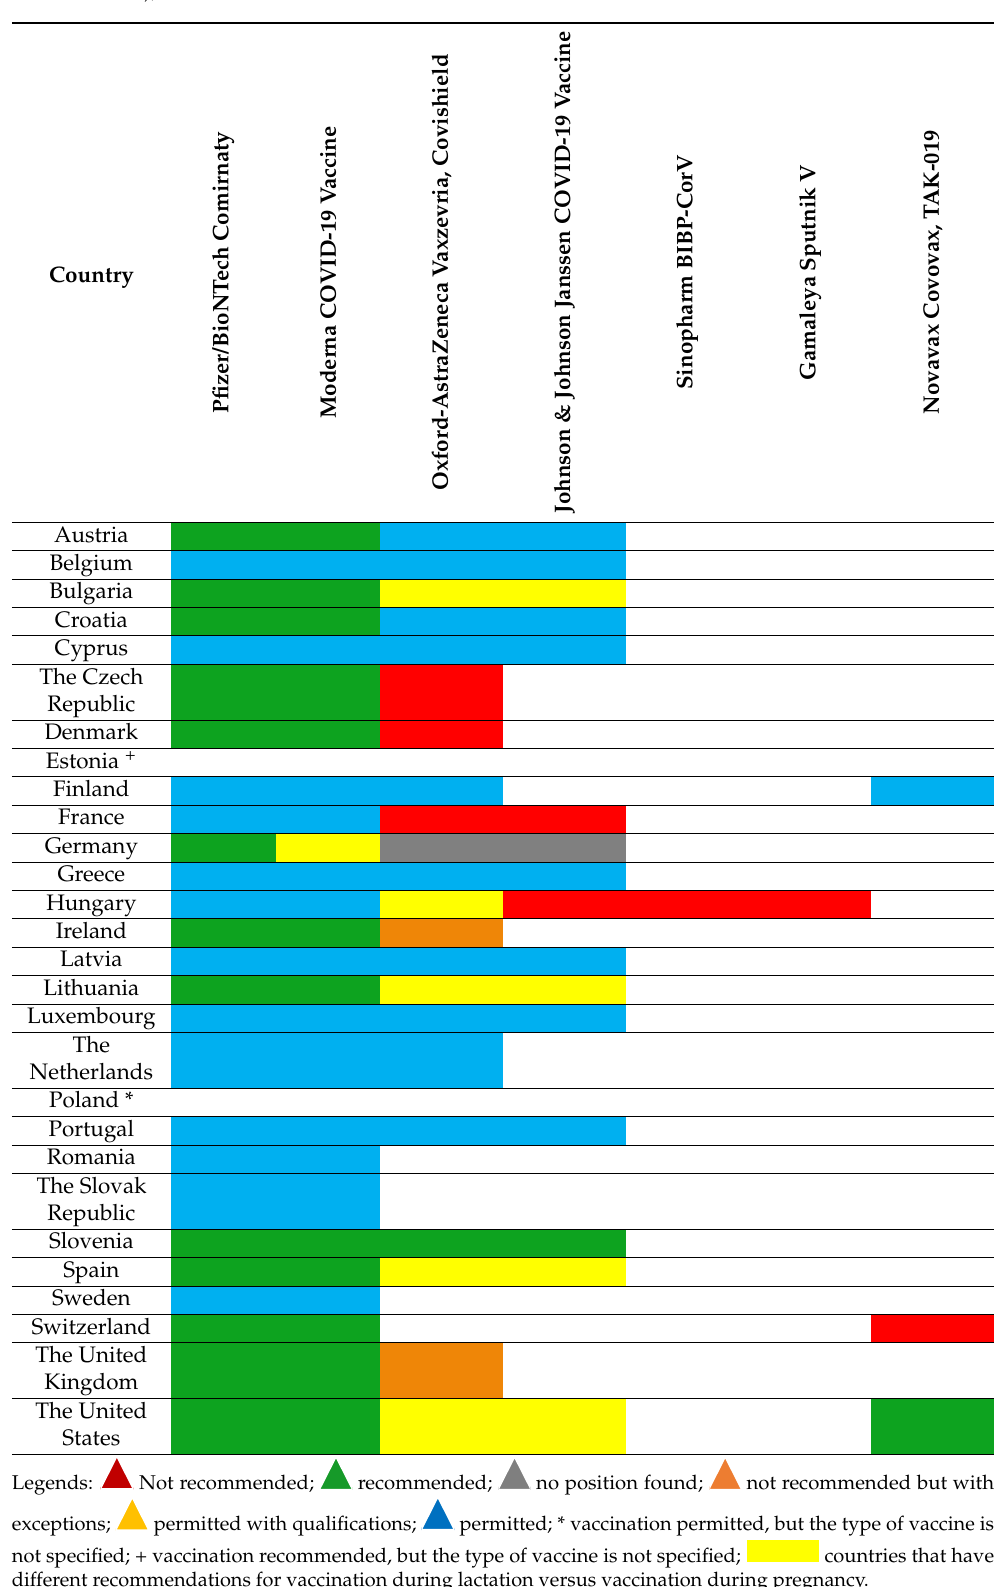
Table 2. Actual policy position for vaccination during lactation, by country (Europe, United Kingdom, United States), for each vaccine.